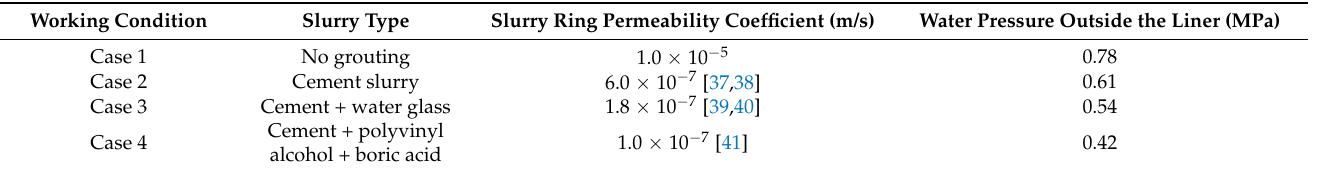
Table 3. Information of four working conditions and water pressure outside the